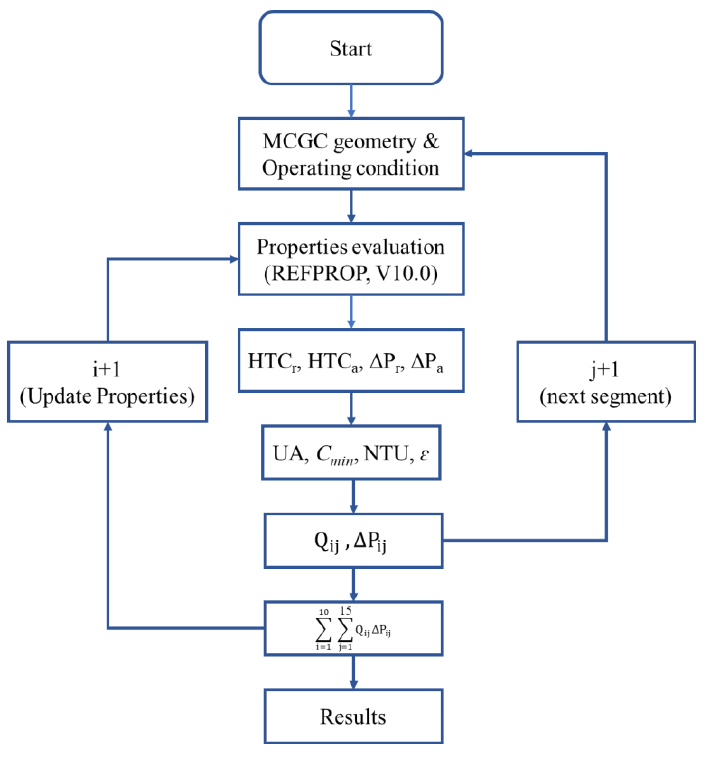
Figure 3. Flow chart of a numerical model for a transcritical CO 2 gas cooler.